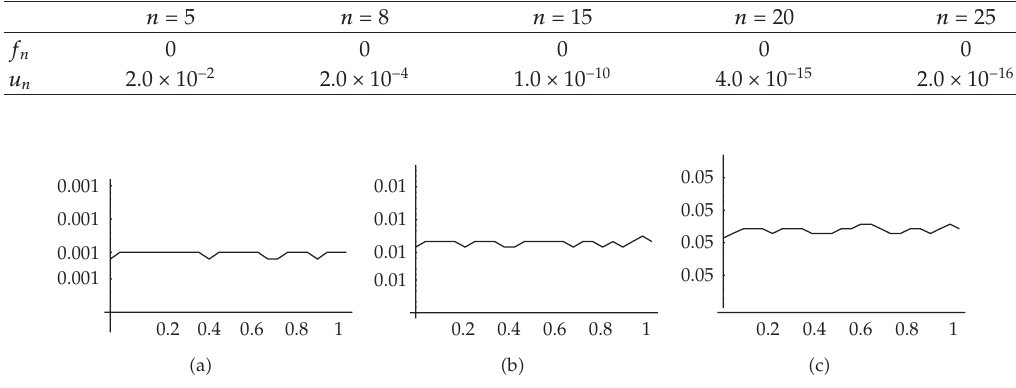
Table 1: Maximum absolute errors of f n and u n with exact input data for Example 4.1.